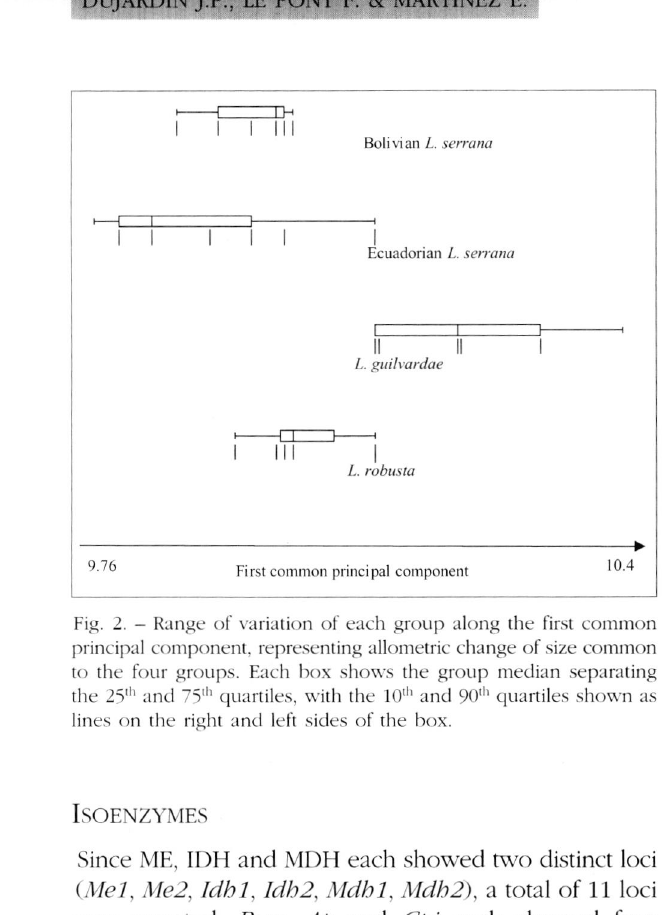
Table II. - Allelic frequencies at 11 loci for Bolivian L . serrana and for L . robusta (Zumba, Ecuador). Alleles are numbered according to the decreasing rate of migration on the gel. N, number of spe cimens. Expected H, expected heterozygosity (Nei, 1987). Rate of gene polymorphism, the proportion of loci presenting genetic varia tion.